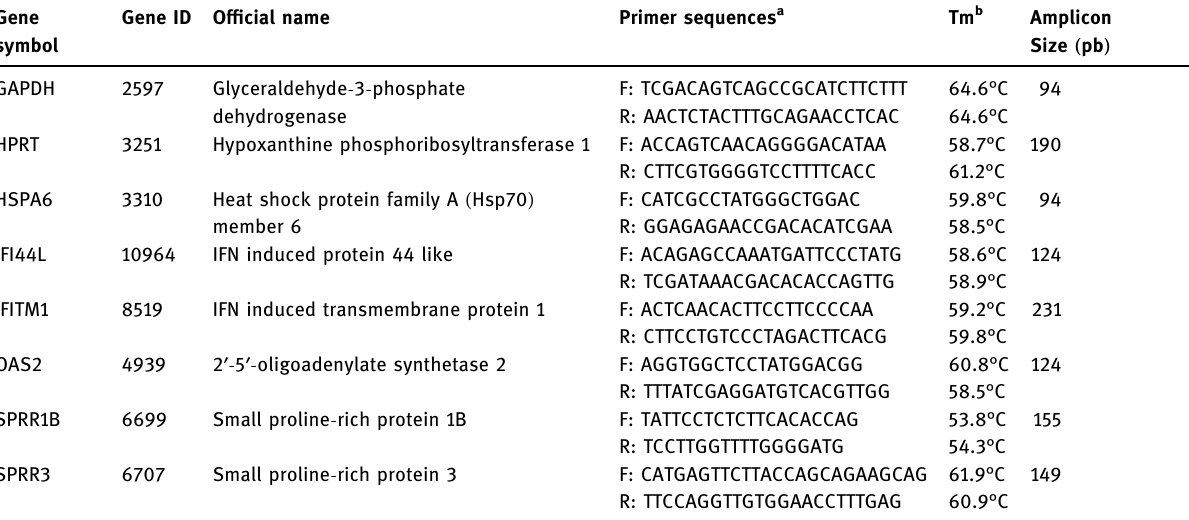
Table 1: Sequences of primers used for real - time qPCR analysis Gene symbol